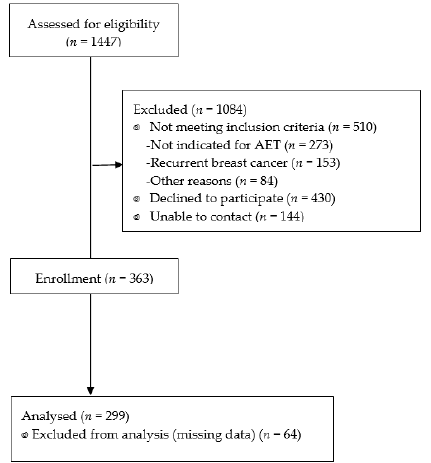
Figure 1. The flow of study participants selection.